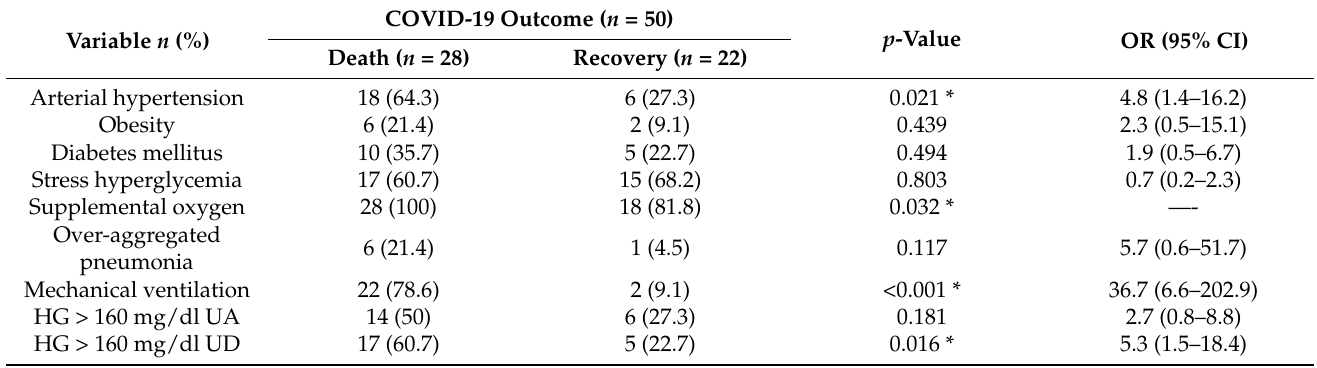
Table 2. Comorbidities and clinical variables of hospitalized patients with COVID-19 included in the